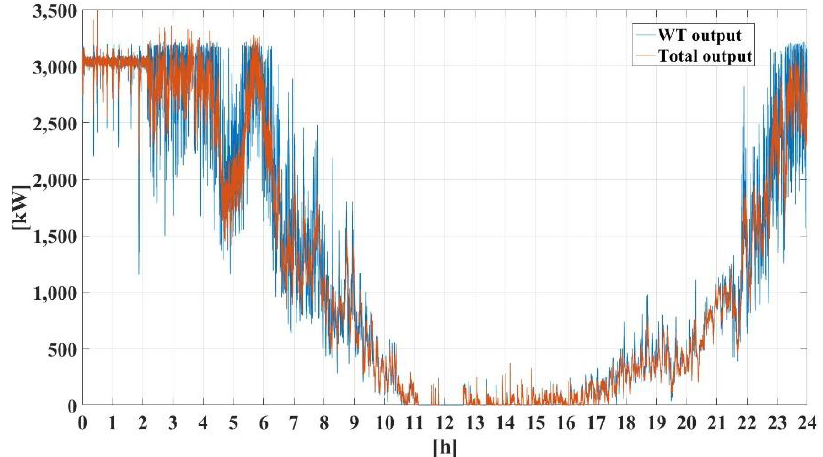
Figure 5. Field test result 1: wind and total output power.